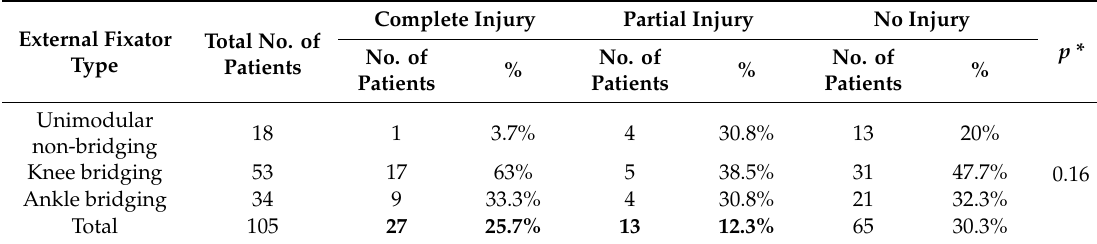
Table 2. The incidence of the TNAC injury in all patients according to the external fixator type.